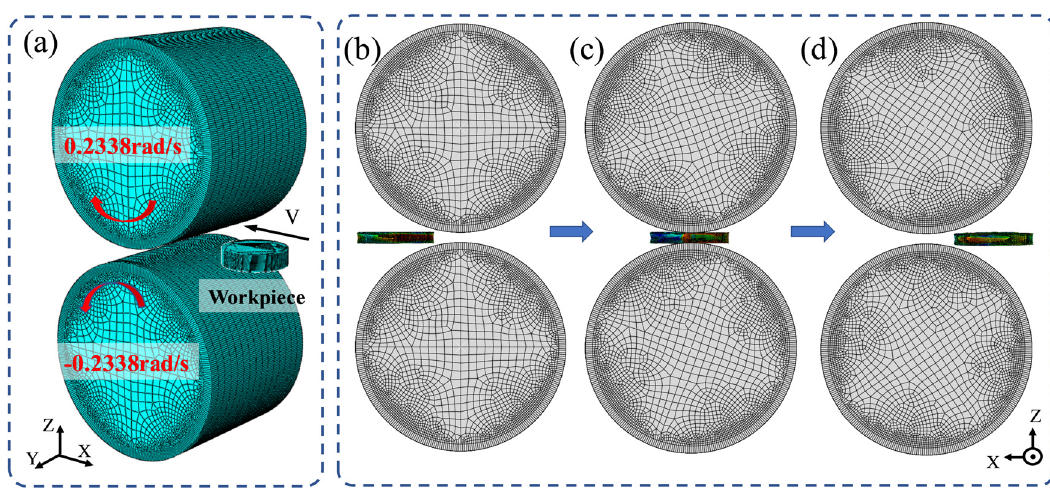
Figure 4: ( a ) FE model of multi - pass rolling: ( b ) before rolling, ( c ) during rolling, and ( d ) after rolling.